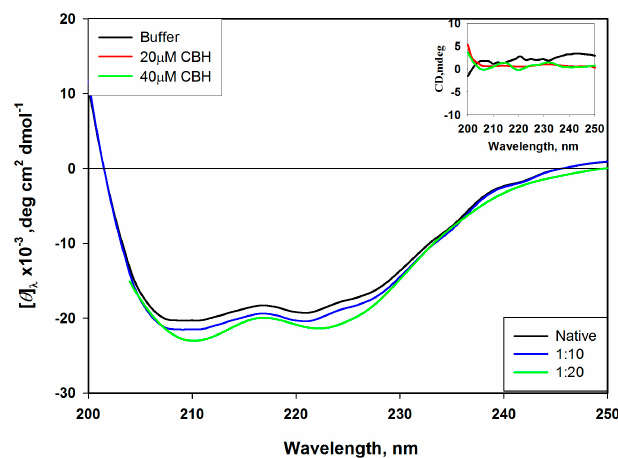
Figure 4. Circular dichroism of the free HSA and HSA–CBH complexes. Circular dichroism (CD) spectra of HSA (2 µ M) in the presence of CBH (10 µ M, 20 and 40 µ M) at pH 7.4. Control spectra of CBH (20 and 40 µ M) and buffer are shown in the inset.